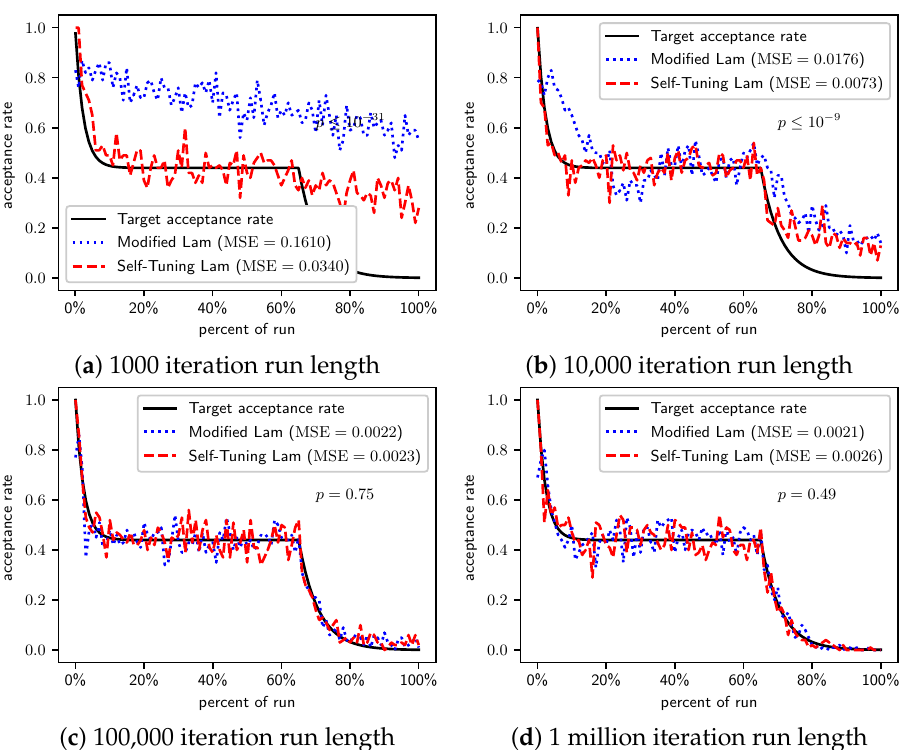
Figure 21. TSP with cities in unit square: Self-Tuning Lam, Modified Lam, and target acceptance rates for ( a ) 1000 iterations, ( b ) 10,000 iterations, ( c ) 100,000 iterations, and ( d ) 1 million iterations.